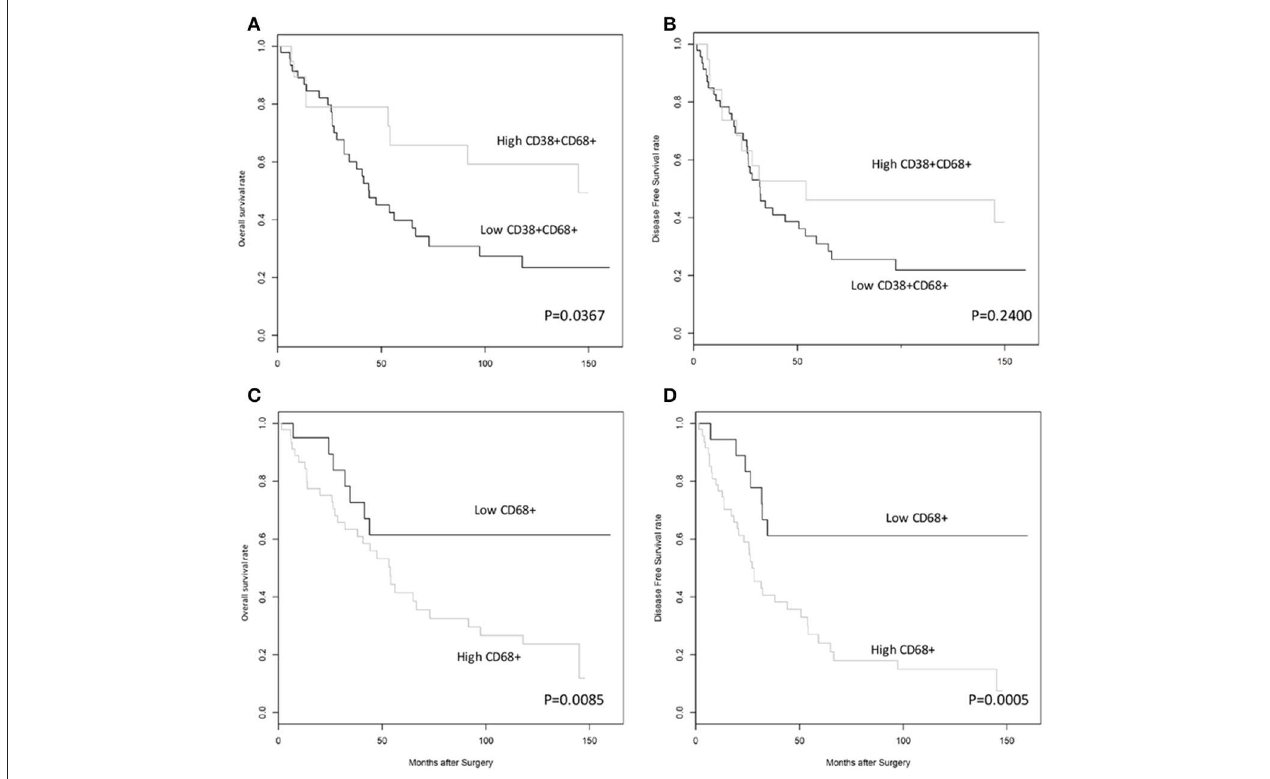
FIGURE 2 | High density of CD38 + , but not total, CD68 + TAMs was associated with improved overall survival rates in patients with HCC. (A,B) Kaplan-Meier curves showing overall and disease free survival rates, respectively, for patients grouped according to high or low density of CD38 + CD68 + macrophages in the tumor microenvironment. (C,D) Kaplan-Meier curves showing overall and disease free survival rates, respectively, for patients grouped according to high or low density of CD68 + total macrophages in the tumor microenvironment. Cut-offs for high/low density of CD38 + CD68 + macrophages (0.5690) and CD68 + total macrophages (0.1918) were based on optimal values calculated using statistical